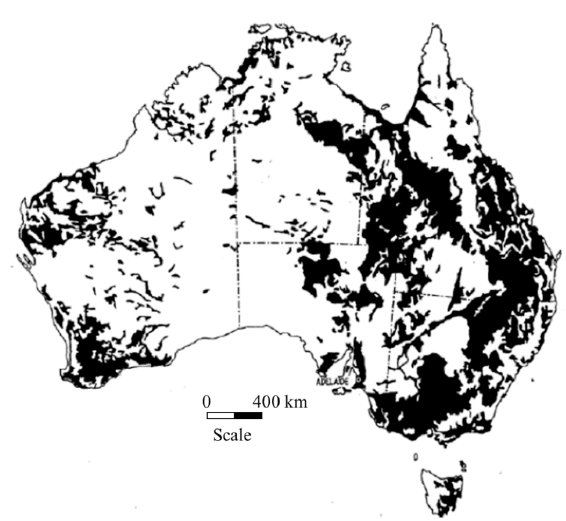
Figure 2. Distribution of moderately to highly expansive soils in Australia (after